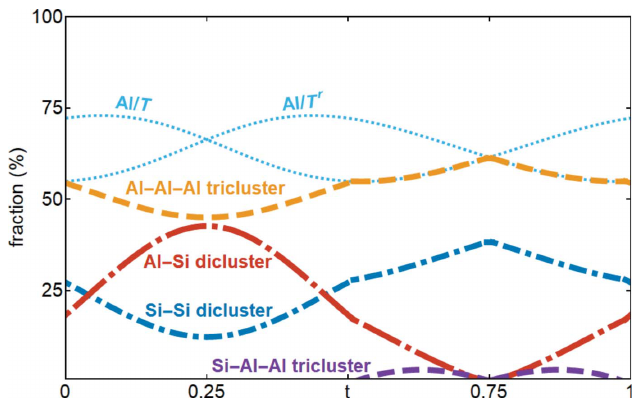
Figure 10 Al/Si ordering trends derived from the normalized occupancies of Al on the T and T r sites (light-blue dotted curves). For example, if the T site is occupied and t = 0.6, then it is either occupied by Al (56% probability) or Si (44% probability). The respective T r site is occupied by 69% Al and the T – T r pair in 59% of the cases is integrated in a tricluster, 56% of the Al–Al–Al type and 3% of the Si–Al–Al type. The remaining fraction form Al–Si and Si–Al diclusters (10% combined) and Si–Si diclusters